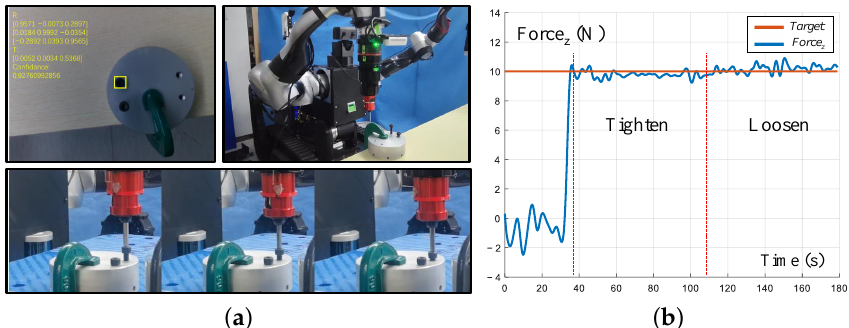
Figure 13. Autonomous operation and end force tracking experiment (see details in Supplementary Video). ( a ) Experiment setup. The workpiece is fixed on the table and screws appear in the field of vision; ( b ) force tracking data in screwing. The contact force is maintained at 10 N in both tighten and loosen